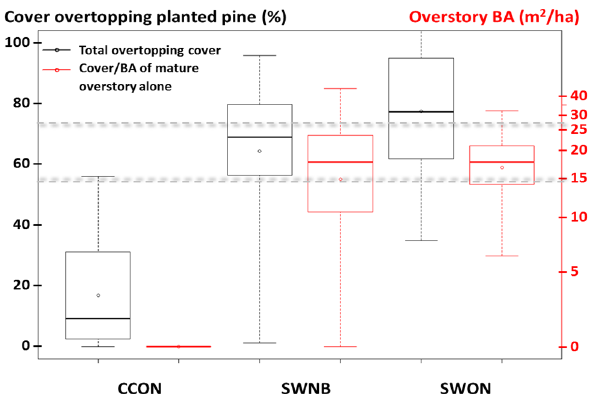
Figure 6. Distribution of overtopping cover (in black; sum of deciduous tree, tall shrub, and overstory covers) and mature tree basal area (in red; m 2 /ha) across the 72 plots at each site. Whiskers reflect maximum and minimum observations; boxes encompass the 25th and 75th quantiles; solid lines reflect the medians; and hollow circles the means. Zone between horizontal dashed lines reflects the overtopping cover range associated with maximum planted pine performance (see Figure 5). Sites are clearcut (CCON) and shelterwood (SWNB and SWON).